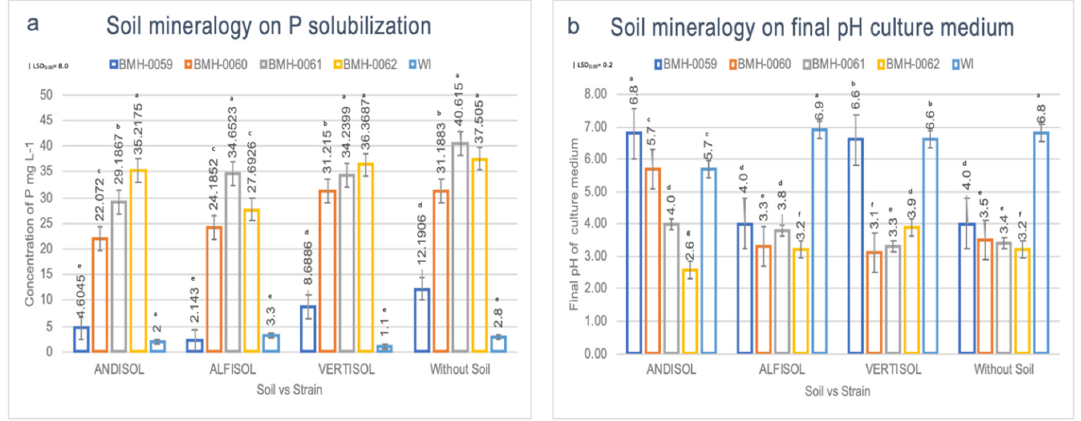
Figure 2. Evaluation of the effect on P solubilization in different soils inoculated with different fungal isolates. ANOVA multiple comparison tests ( a ) soluble P (H 2 PO 4 − ) ( | LSD 0.05 = 8.0), and ( b ) final pH of the culture medium. (| LSD 0.05 = 0.2). Three soils with different mineralogy were evaluated: Andisol, Alfisol, and Vertisol, and a control Without Soil (SI) with four different fungal strains Bars represent the standard error. All values shown are the average of four replicates per treatment ( P ≤ 0.01).